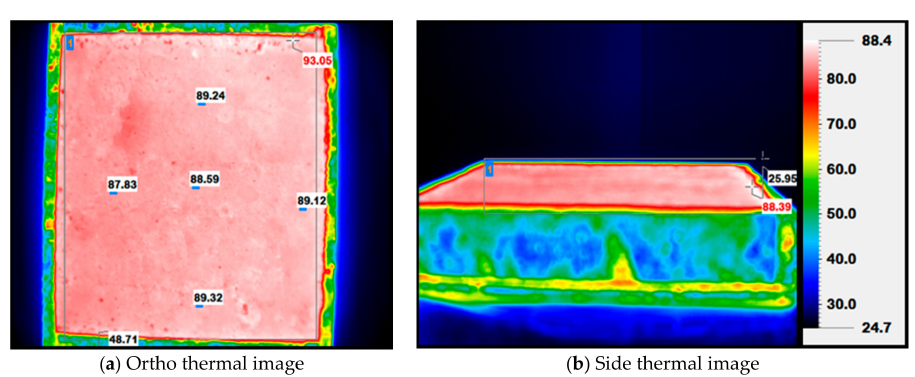
Figure 10. PA-graded mixture thermal image ( ◦